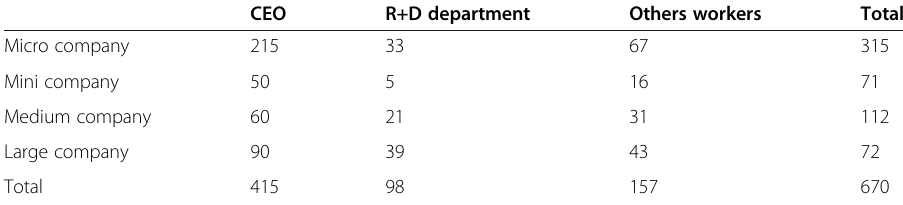
Table 2 Individual employee groups that are a source of innovation CEO